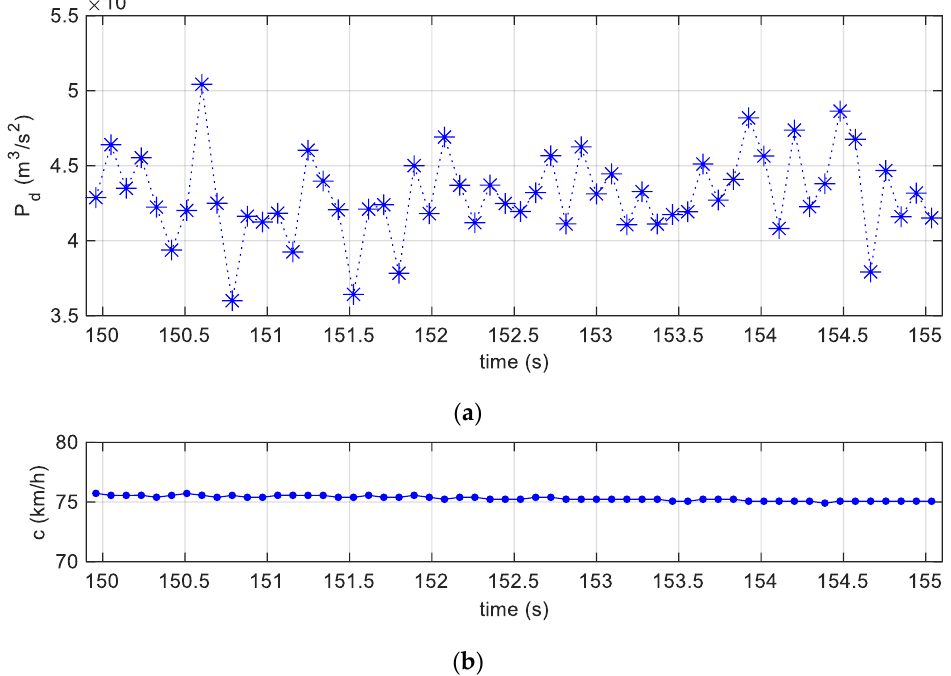
Figure 10. ( a ) Specific dissipated power between 150 and 155 s; ( b ) the uniform tyre speed over the selected time interval between 150 and 155 s.